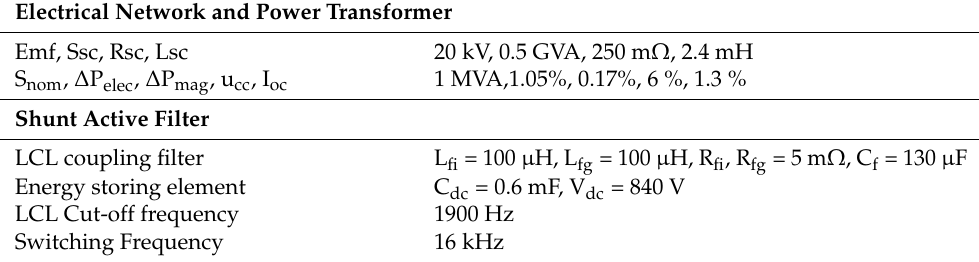
Table 1. Rated values of the electrical grid. Electrical Network and Power